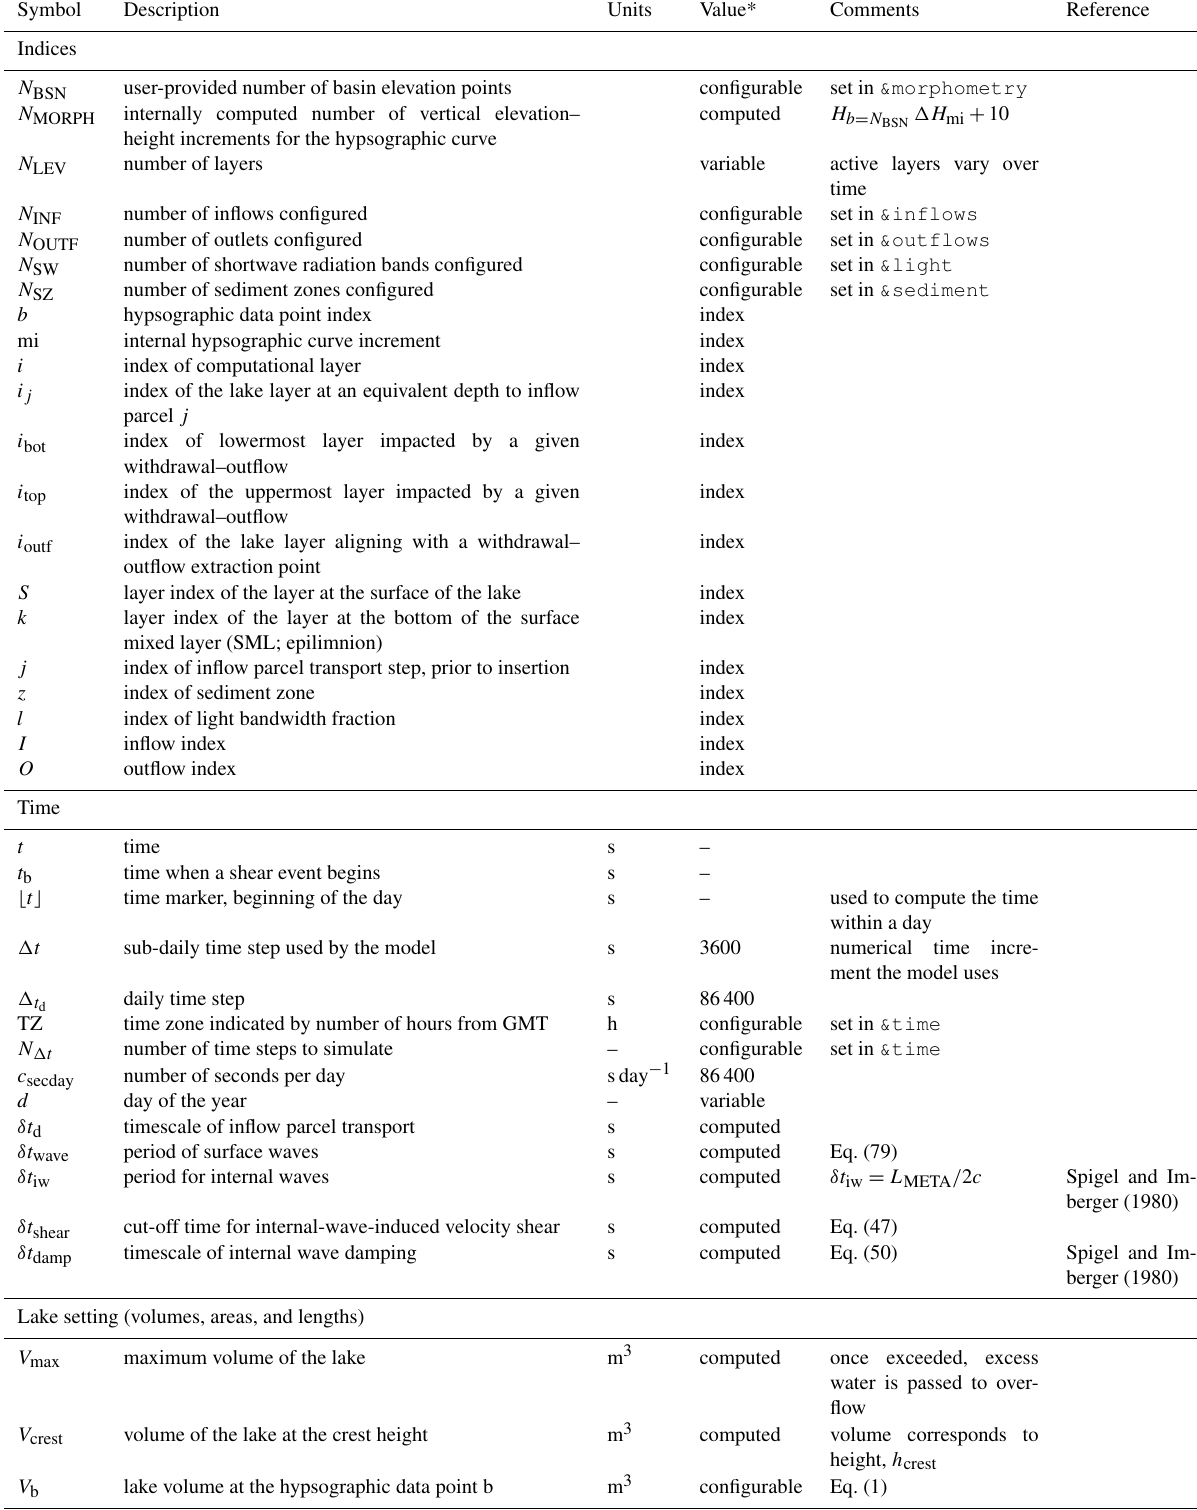
Table 1. Summary of GLM notation with values for constants, suggested (default) values for parameters, and supporting information and references, where